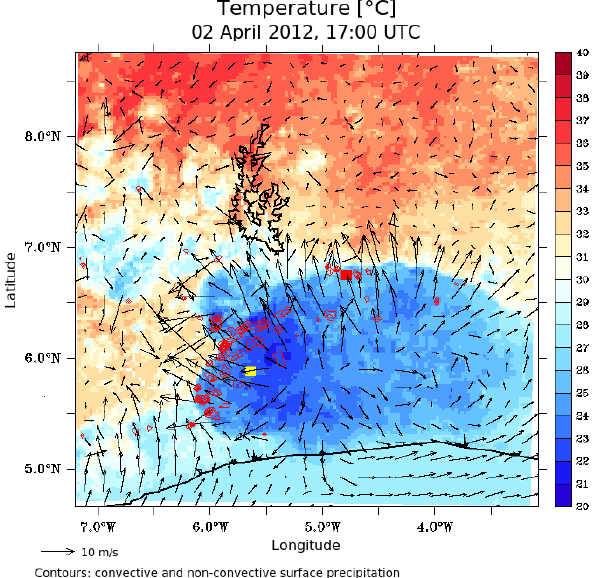
Fig. 9. Real simulation. Horizontal cross section of surface temper- ature field on 2 April 2012 at 17:00UTC. The positions of IS17 (6.670 ◦ N, 4.850 ◦ W) and VS17 (5.80 ◦ N, 5.70 ◦ W) are indicated by a red and a yellow square symbol, respectively. Contours of con- vective plus nonconvective surface rain water mixing ratio are over- plotted, as are wind vectors. The length of an arrow is proportional to wind intensity, as indicated in the figure’s legend.